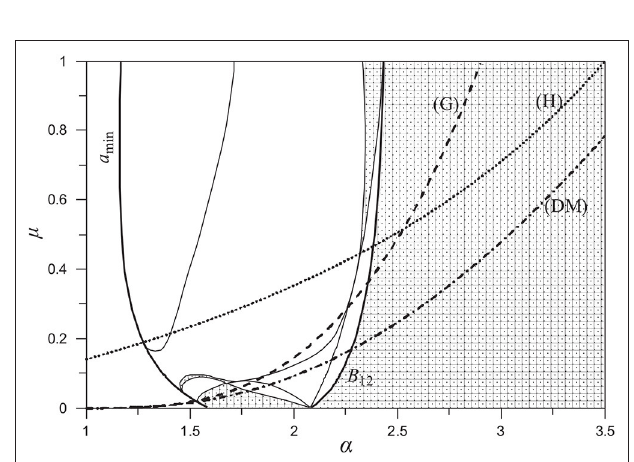
FIGURE 6 | The stable (dotted) regions of the manifold P c and limit curves of stability criteria defined by Harrington (H), Donnison&Mikulskis (DM), and Gladman